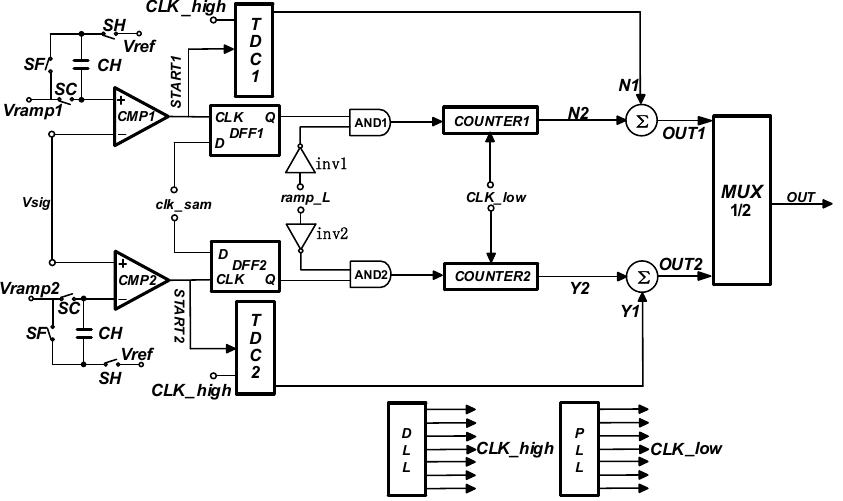
Figure 7. Schematic of the proposed circuit.